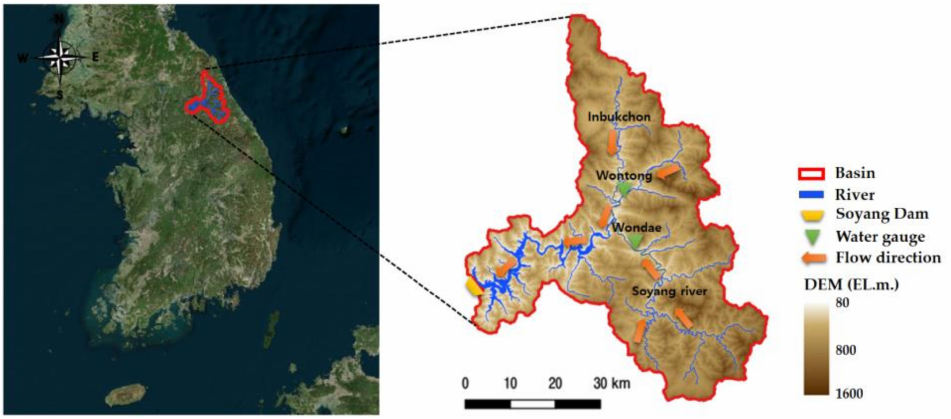
Figure 5. Target